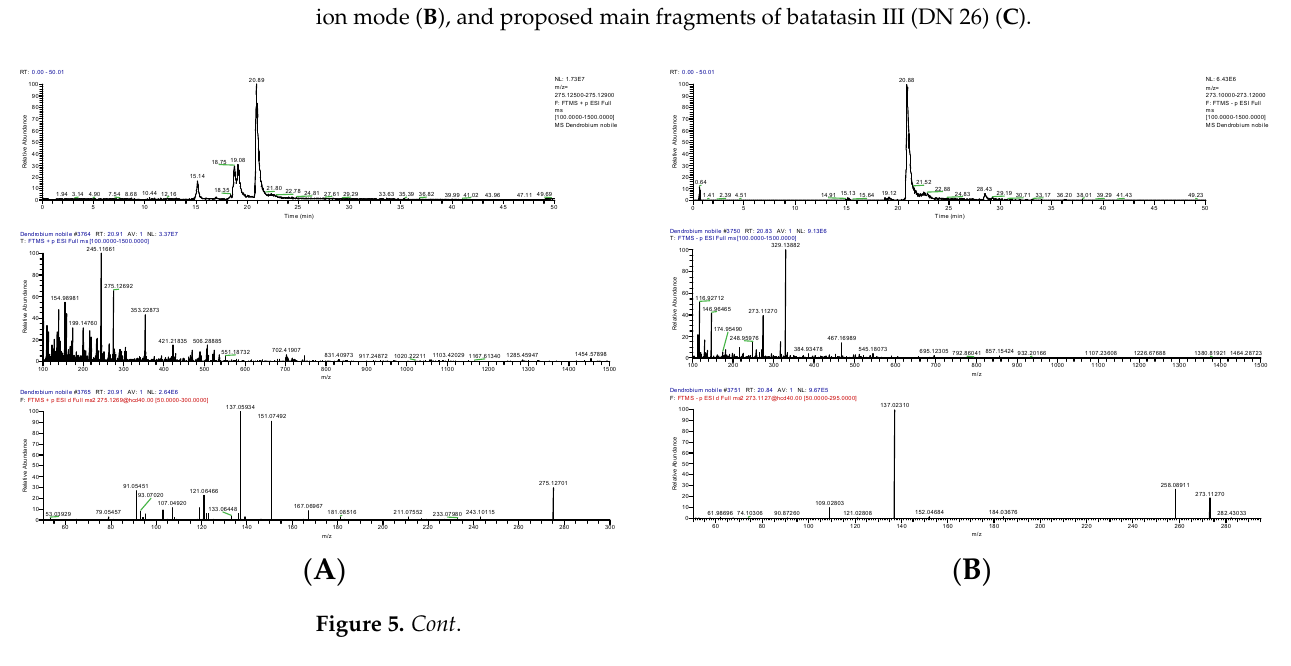
Figure 4. Extracted ion chromatogram: MS 1 and MS 2 spectra in positive ion mode ( A ) and negative ion mode ( B ), and proposed main fragments of batatasin III (DN 26) ( C ).